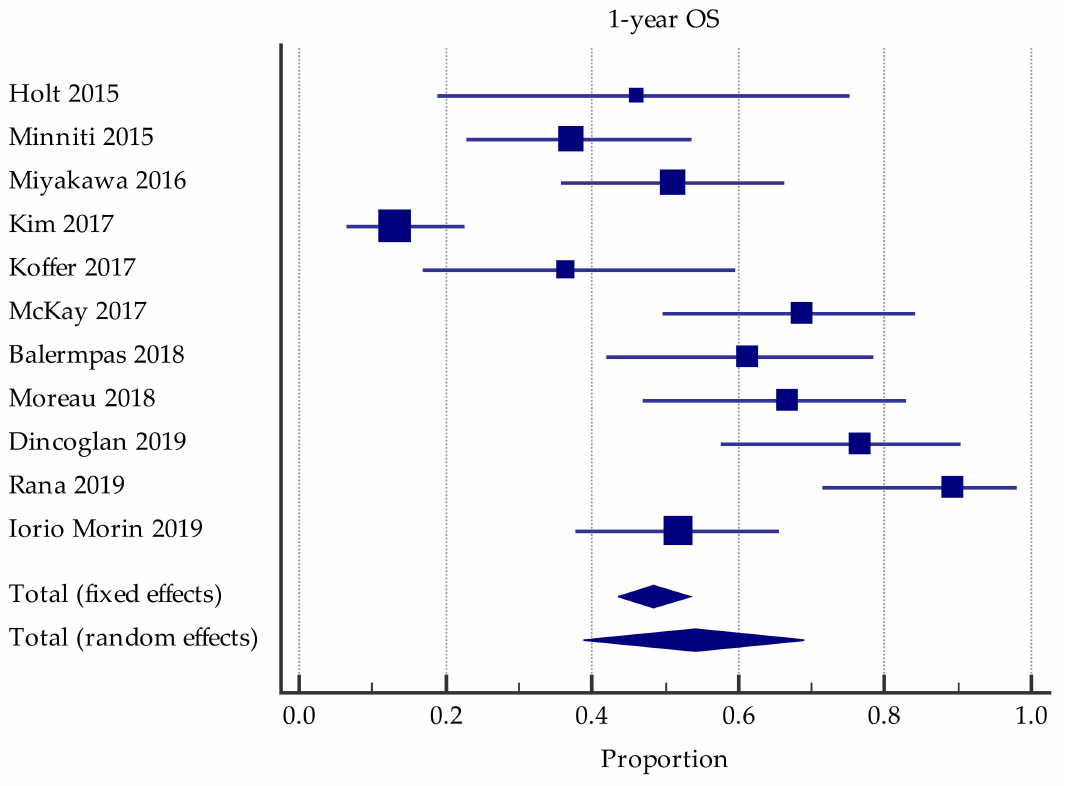
Figure 2. Forest plot of studies evaluating SRS2/SRT2: effect on 1-year overall